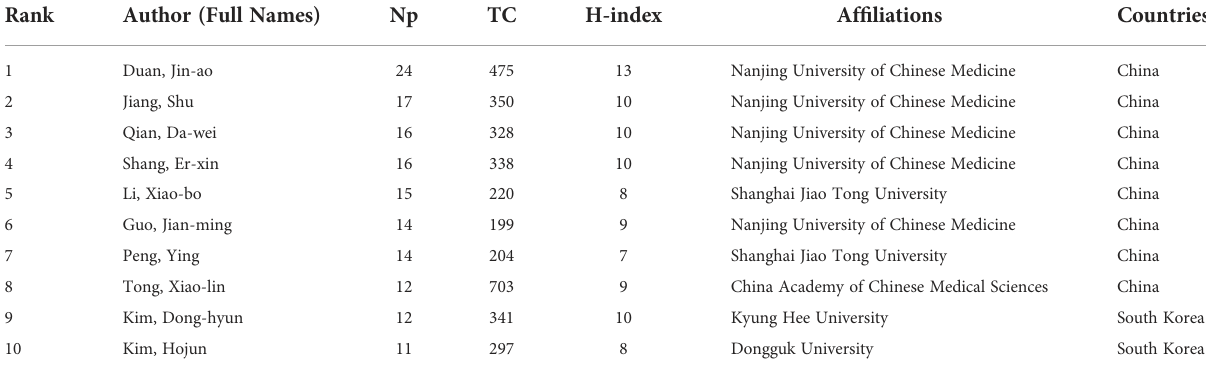
TABLE 2 The top 10 productive authors in the